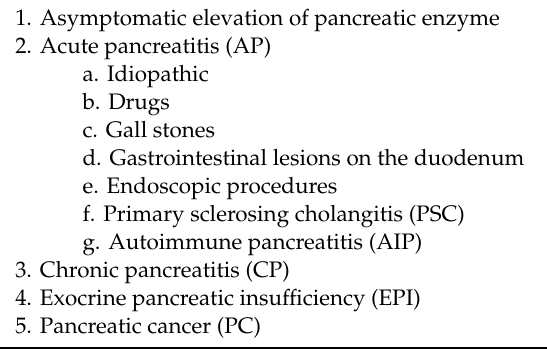
Table 1. Pancreatic manifestations accompanied by inflammatory bowel